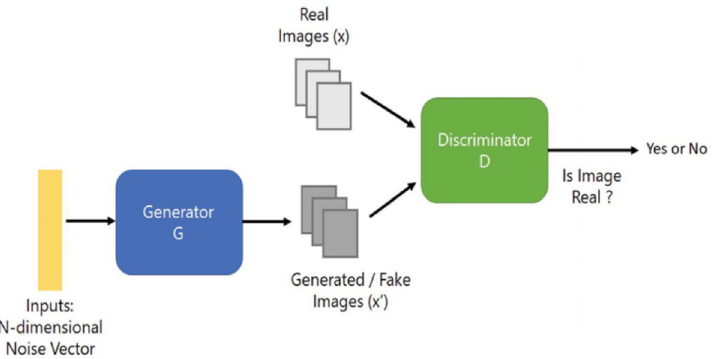
Fig 1. DCGAN structure